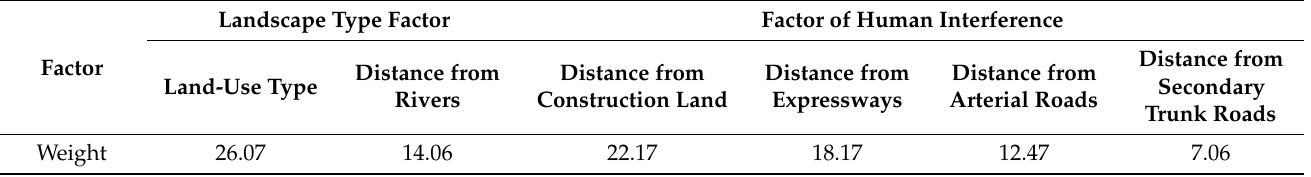
Table 4. The integrative weights of the resistance factor.